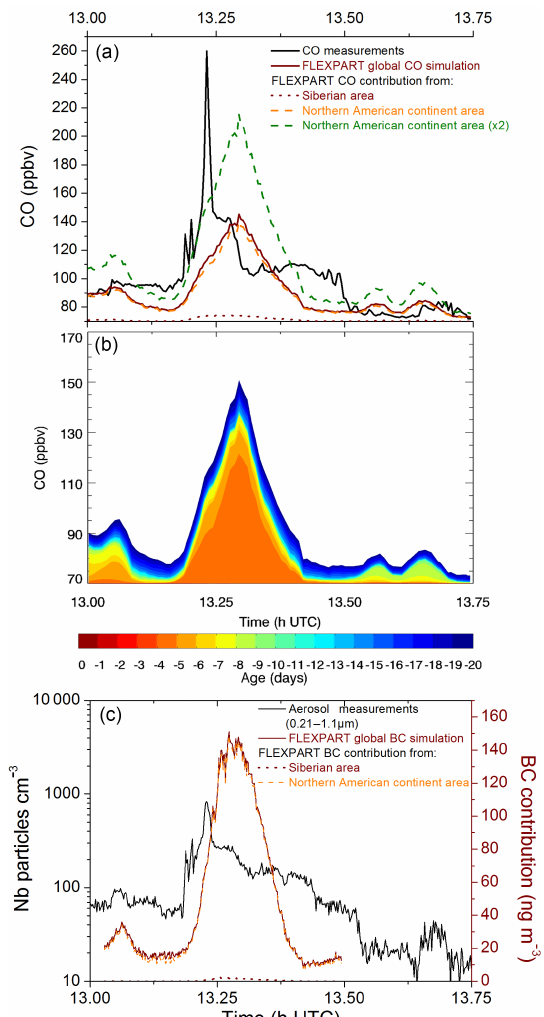
Figure 3. Zoom on a part of F8 from 13:00 to 13:45UTC above Sardinia at 9.7kma.s.l. with an injection height up to 10km in FLEXPART. (a) CO time evolution along the flight: SPIRIT mea- surements (degraded to FLEXPART time resolution) and FLEX- PART simulations. (b) CO contributions calculated by FLEXPART, colour-coded according to the age, from 1 to 20 days before F8, of the air mass. (c) BC time evolution along the F8 flight: PCASP mea- surements (degraded to FLEXPART time resolution) and FLEX- PART